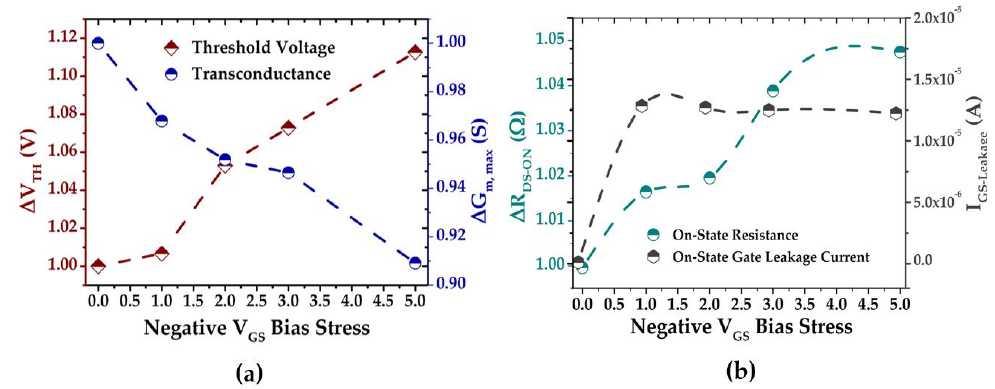
Figure 4. Extracted ( a ) (cid:52) V TH and (cid:52) G m, max and ( b ) (cid:52) R DS-ON and I GS-Leakage under low-voltage pulsed stress